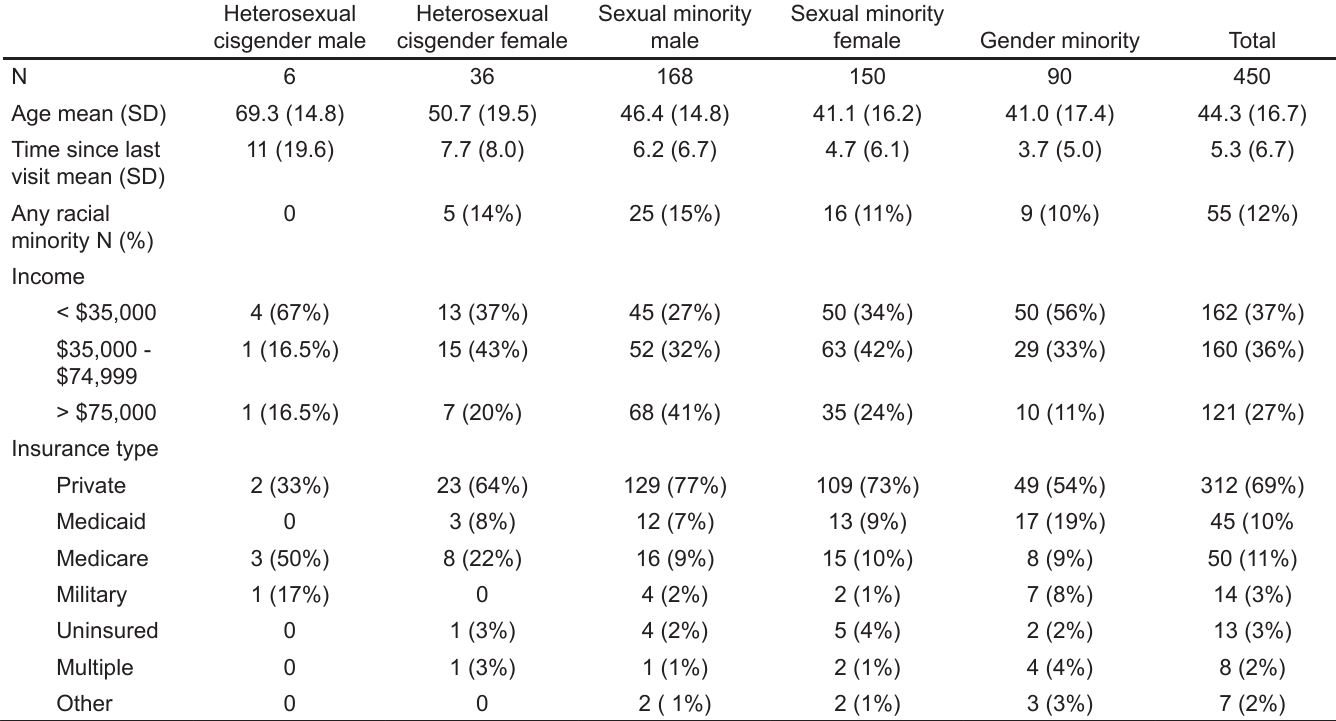
Table 1. Summary characteristics of the survey